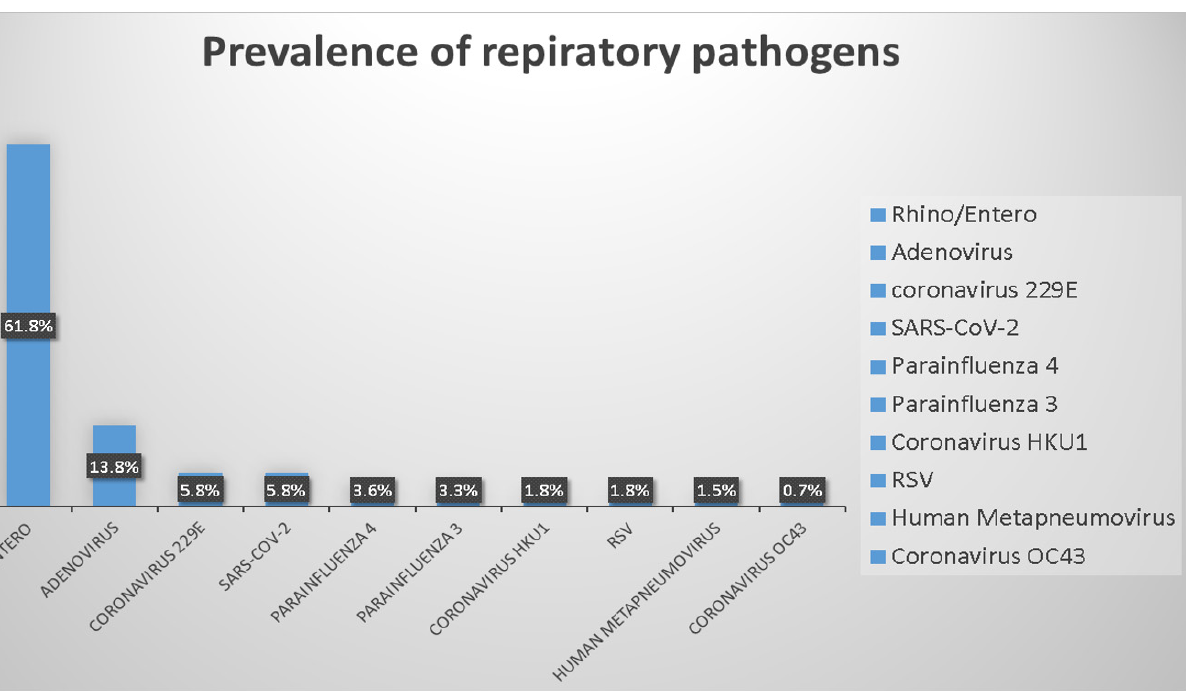
Figure 2. Monthly distribution of isolation rates of rhinovirus/enterovirus from emergency patients in central Taiwan from May 2021 to September 2022.